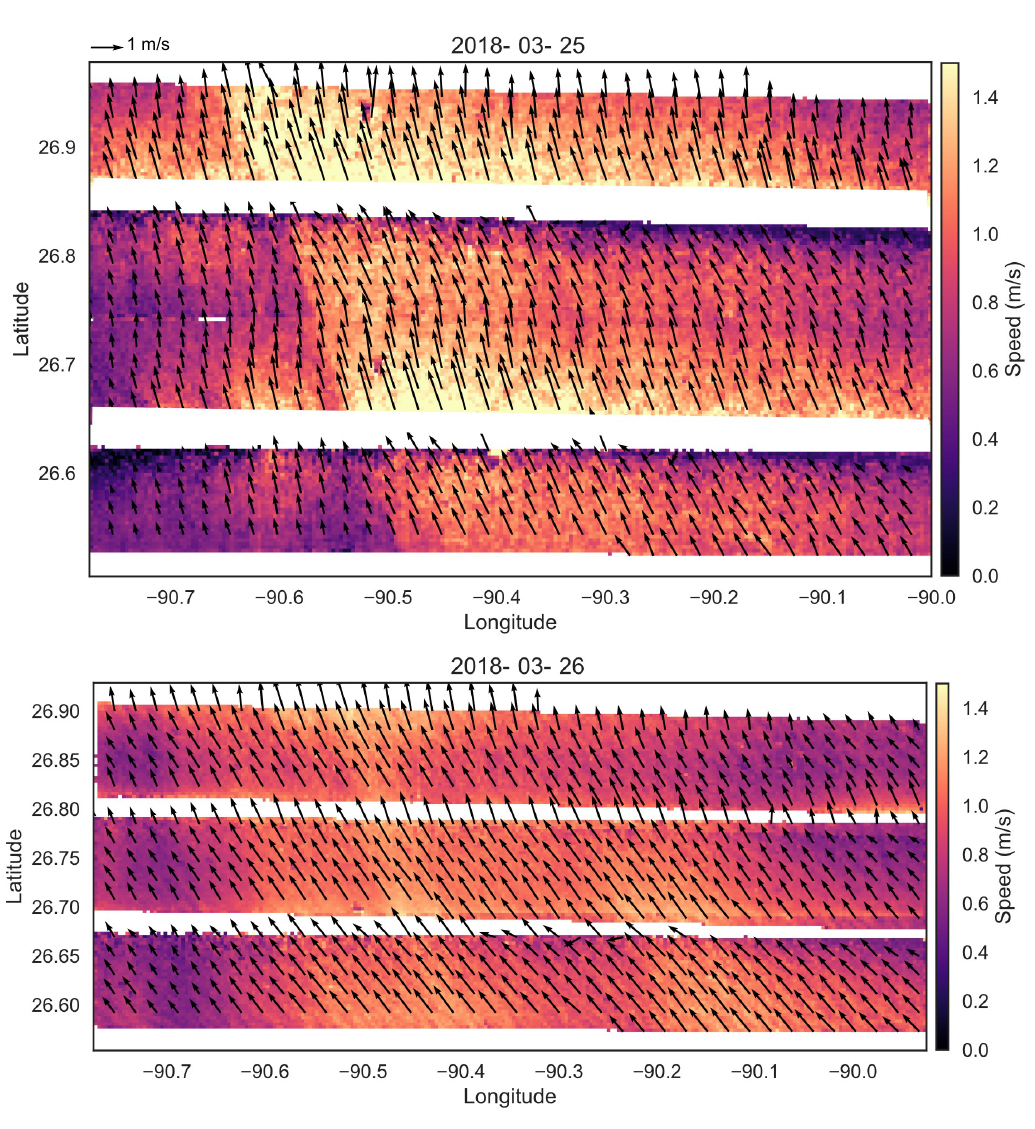
Figure 18. Estimated DopplerScatt surface currents for March 25 (upper panel), and March 26 (lower panel), 2018. Color represents the surface current speed and the arrows (undersampled for clarity) the surface current